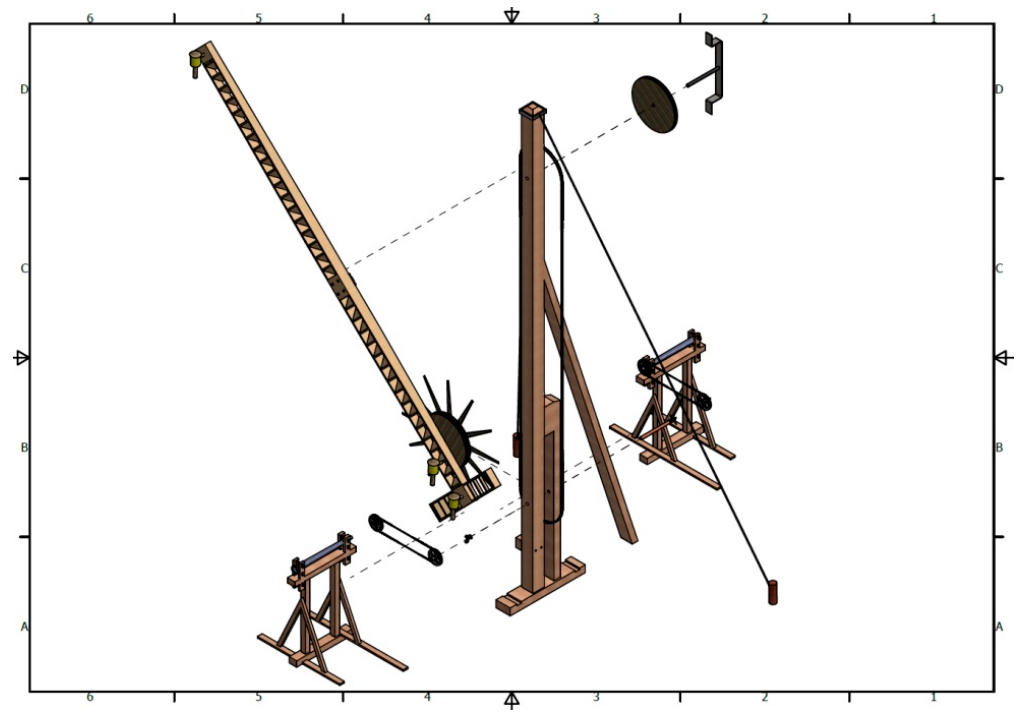
Figure 6. Exploded view of the 3D CAD model.